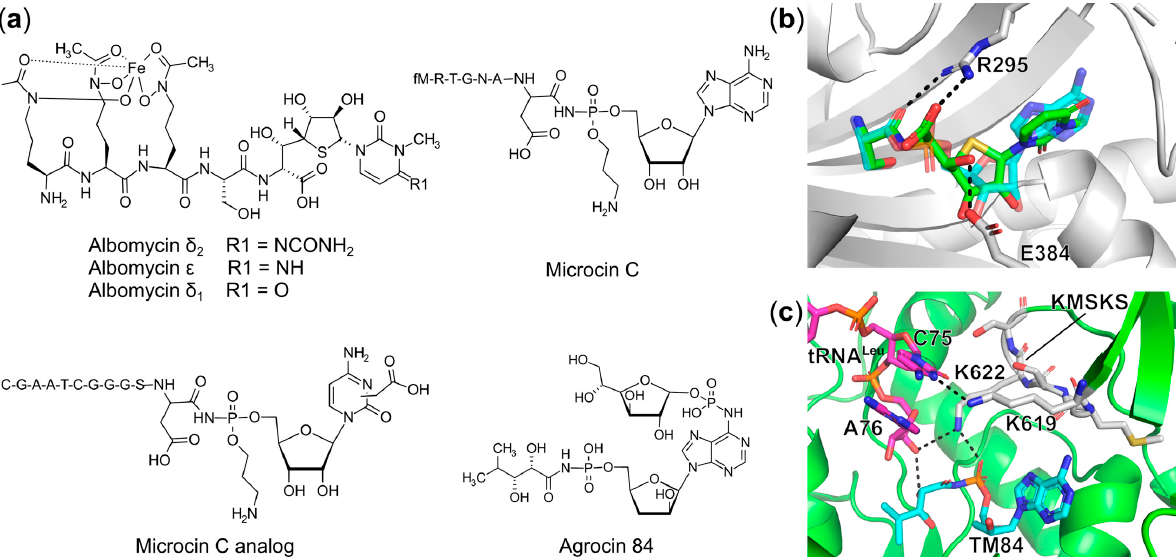
Figure 9. Trojan horse aaRS inhibitors. ( a ) Chemical structures of trojan horse aaRS bi-substrate inhibitors. ( b ) Comparison of the binding modes of the active component of albomycin δ 1 (green C-atoms) and seryl-adenylate (Ser-AMP, cyan C-atoms) in the active site of T. brucei SerRS. The protein structure is shown as a grey cartoon representation with selected side chains as sticks. H-bonds are shown as black dashed lines. ( c ) Ternary structure of E. coli LeuRS in complex with tRNA Leu (magenta C-atoms) and TM84 (cyan C-atoms; PDB entry: 3ZGZ). The protein backbone is shown as a green cartoon diagram. The KMSKS sequence motif, the inhibitor TM84, and 3 (cid:48) -end of tRNA Leu are shown as sticks and all H-bond interactions are shown as black dashed